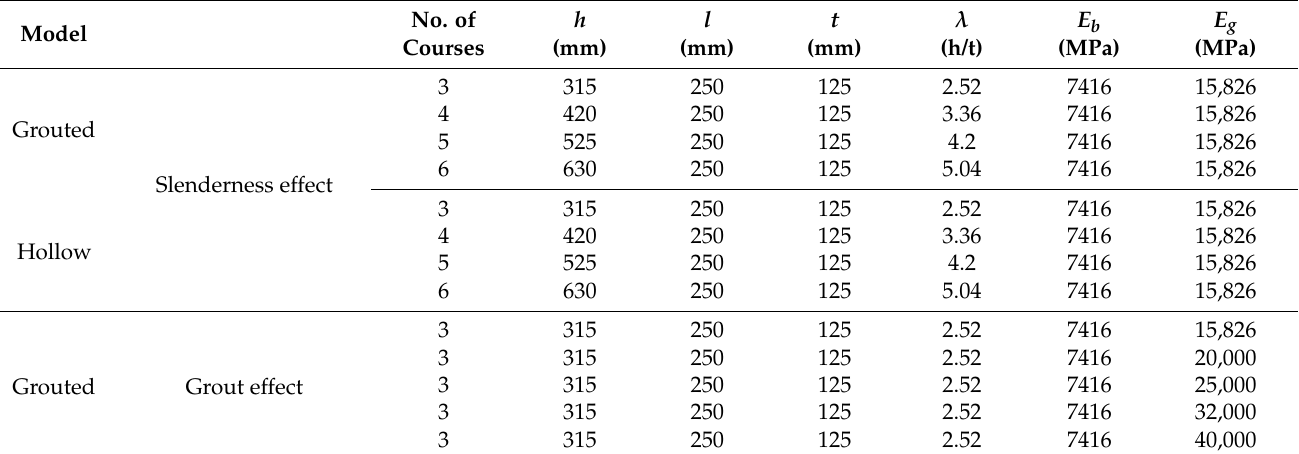
Table 3. Details of FE model for parametric study.